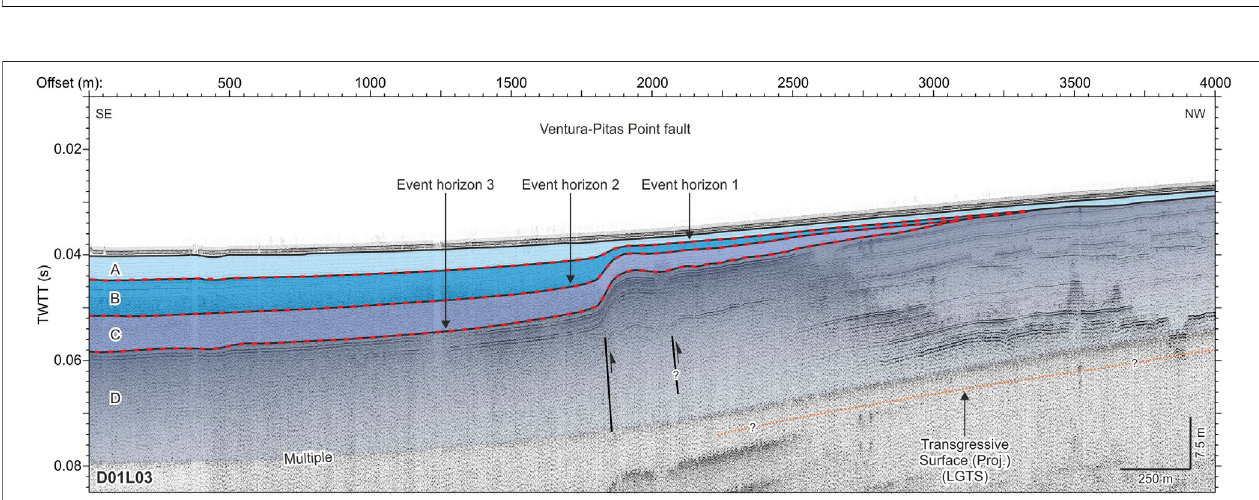
Frontiers in Earth Science |